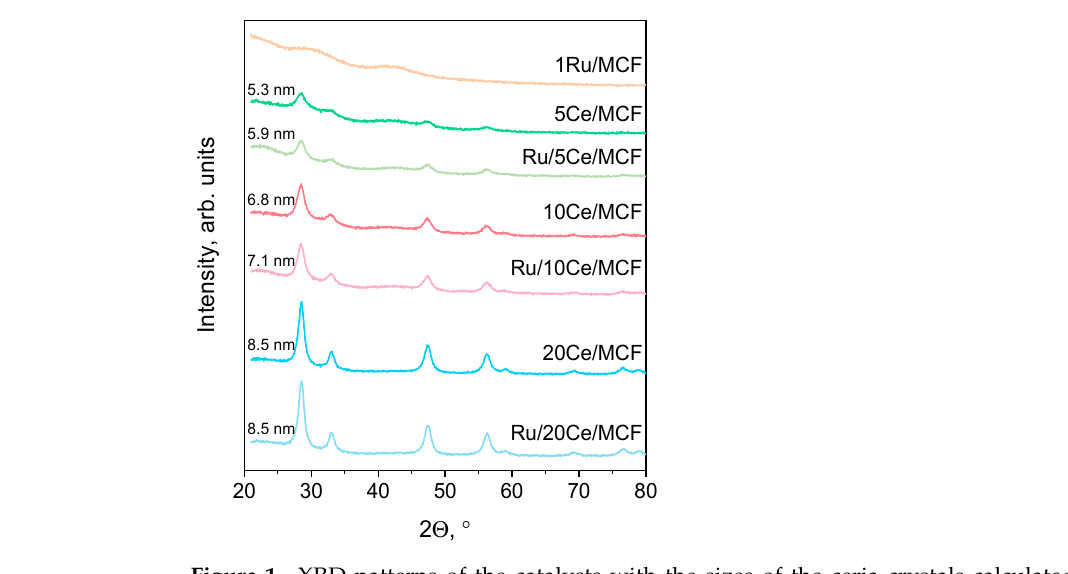
Figure 1. XRD patterns of the catalysts with the sizes of the ceria crystals calculated from the Scherrer equation. Table 3. XPS results obtained from the Ru 3p 3/2 and Ru 3 d 5/2